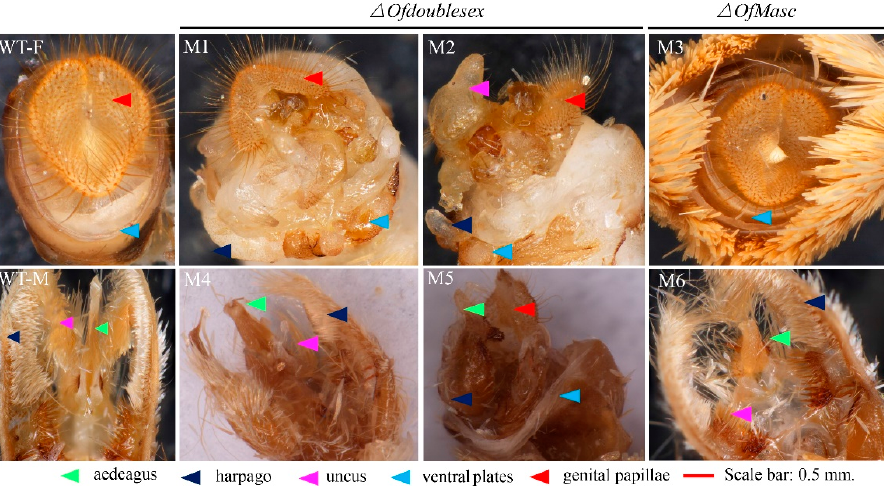
Figure 2. The morphologies of wild type compared with OfMasc and Ofdsx mutant pupae. In the wild type, the females and males have different gonopore characteristics in pupa morphology; these variations are key to differentiating males from females. Female pupae have an X-shaped line and small crevice in the eighth abdominal segment, whereas male pupae develop two prominent points at the abdomen end in the ninth abdominal segment. The OfMasc and Ofdsx mutants showed abnormal or defected morphologies. M1–M3 are the male mutants of Masc in O. furnacalis . In the dsx mutants, M4–M6 are the female mutants; M7–M9 are the intersex mutants; M10–M12 are the male mutants. Scale bar: 1 mm.